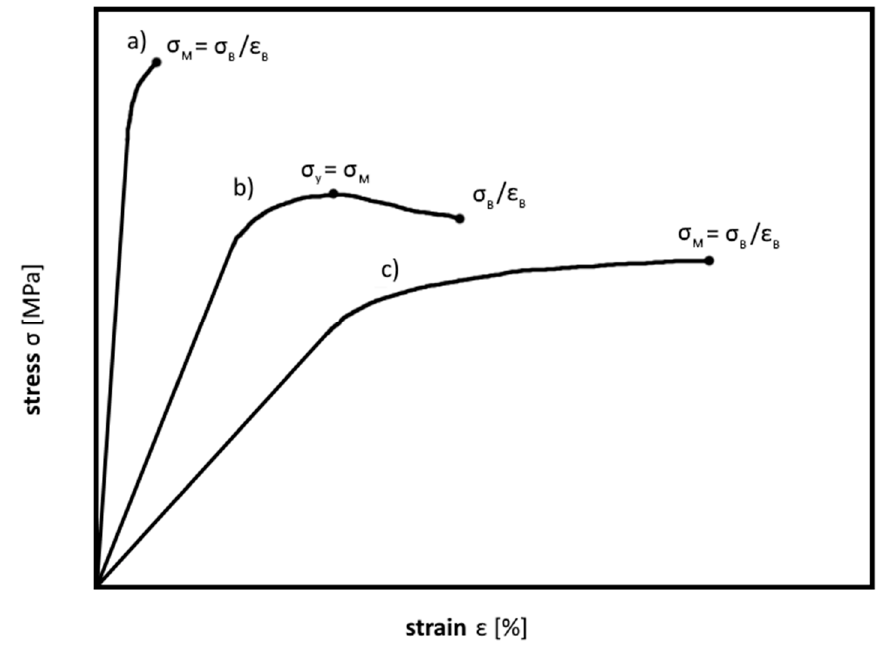
Figure 6. Flexural stress–strain curves of various polymeric materials, ( a ) brittle materials, ( b , c ) tough